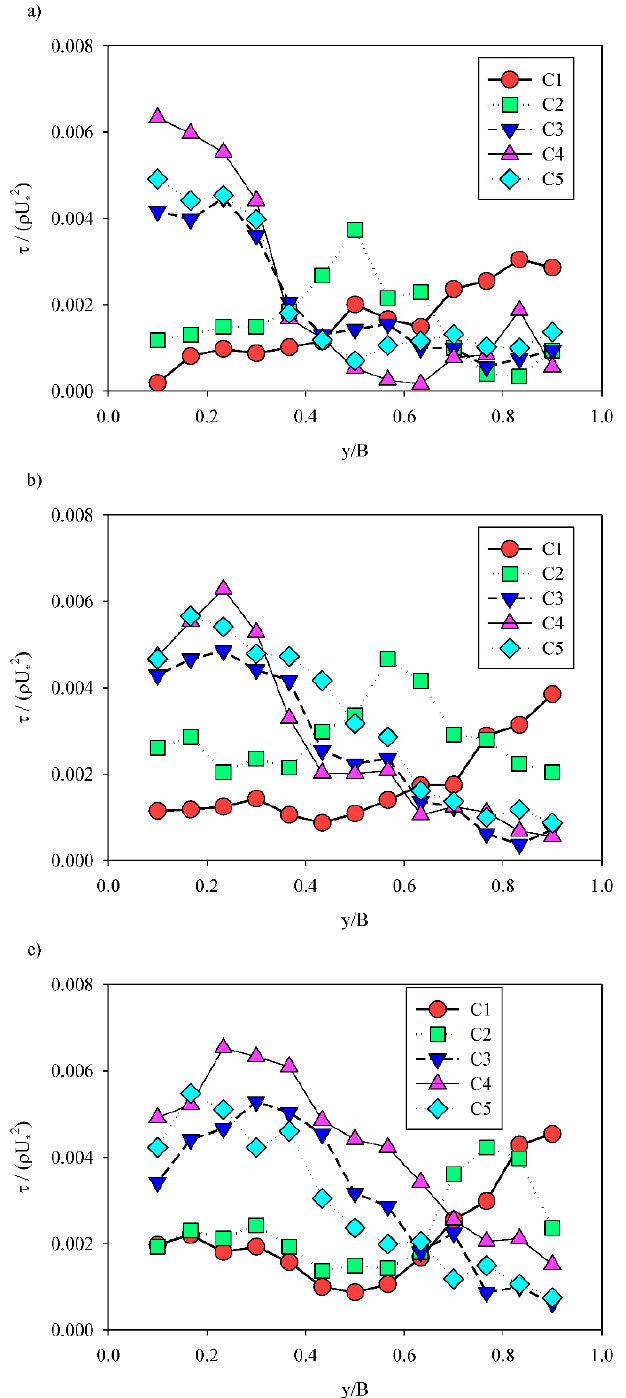
Figure 9. Effect of cylindrical rods on normalized bed shear stress: ( a ) Test 4 (without cylindrical rods), ( b ) Test 5 (Model SR) and ( c ) Test 6 (Model DR).